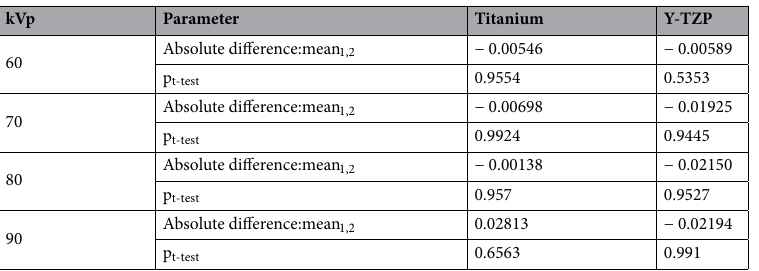
Table 3. Method error as absolute transmission differences between the two experiments. P-values (paired t-test) comparing Transmission in experiment 1 and 2 are also indicated. All values are computed over all intensities along the projection line within the implant image in Fig.